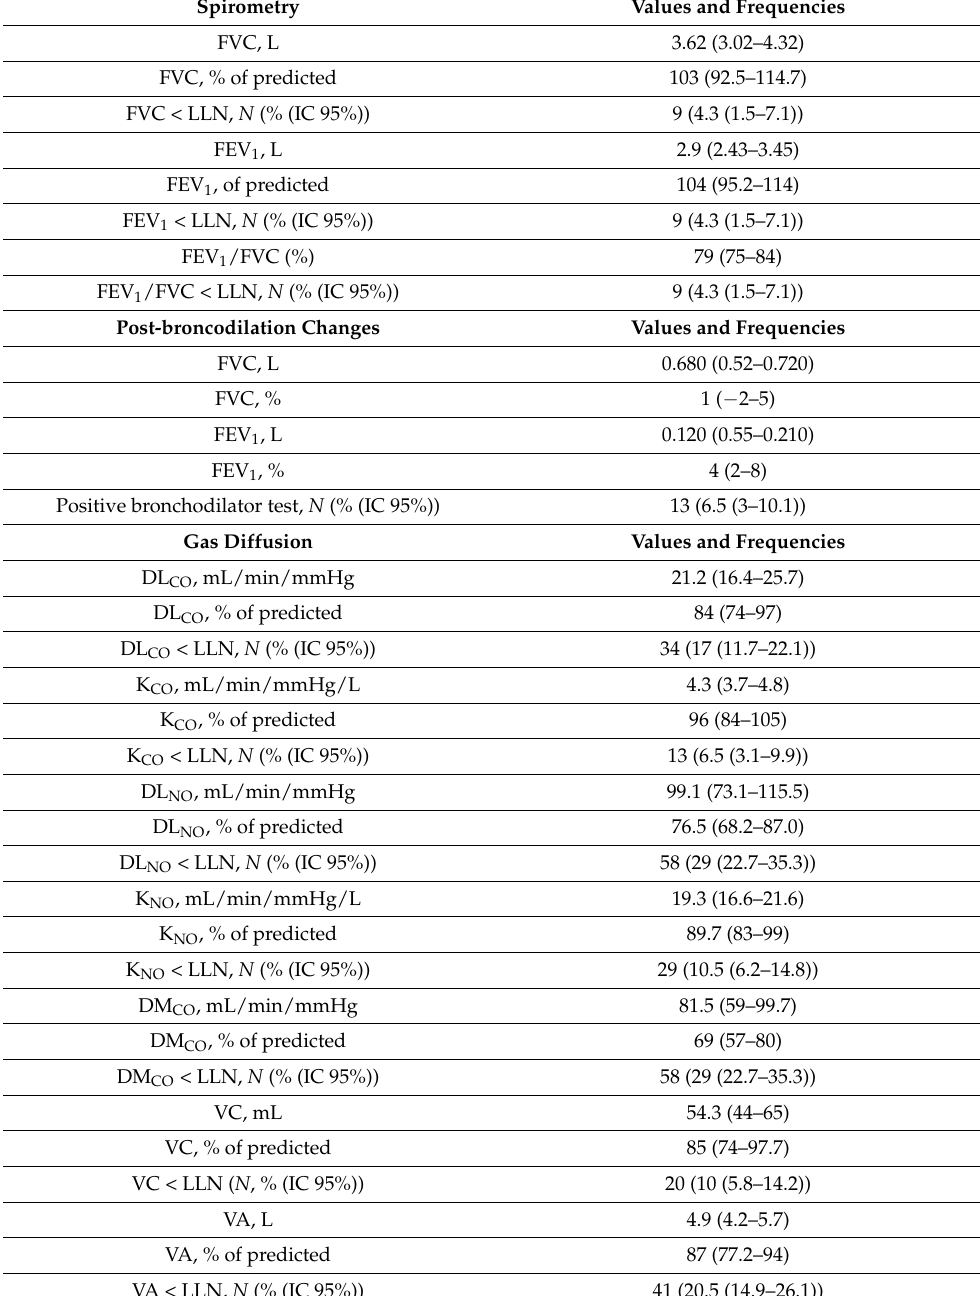
Table 2. Results of respiratory function tests at 12